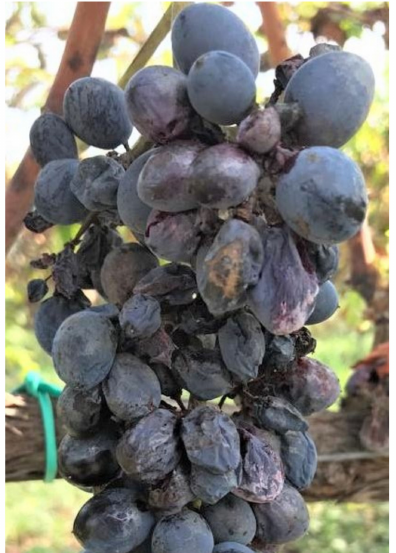
Figure 4. Symptoms observed on bunches of Nero d’Avola caused by sour